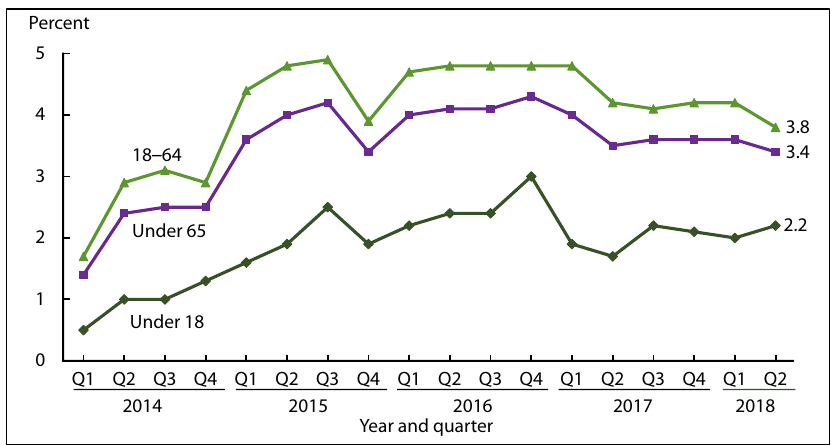
Figure 8. Percentage of persons under age 65 with private health insurance obtained through the Health Insurance Marketplace or state-based exchanges, by age group and quarter: